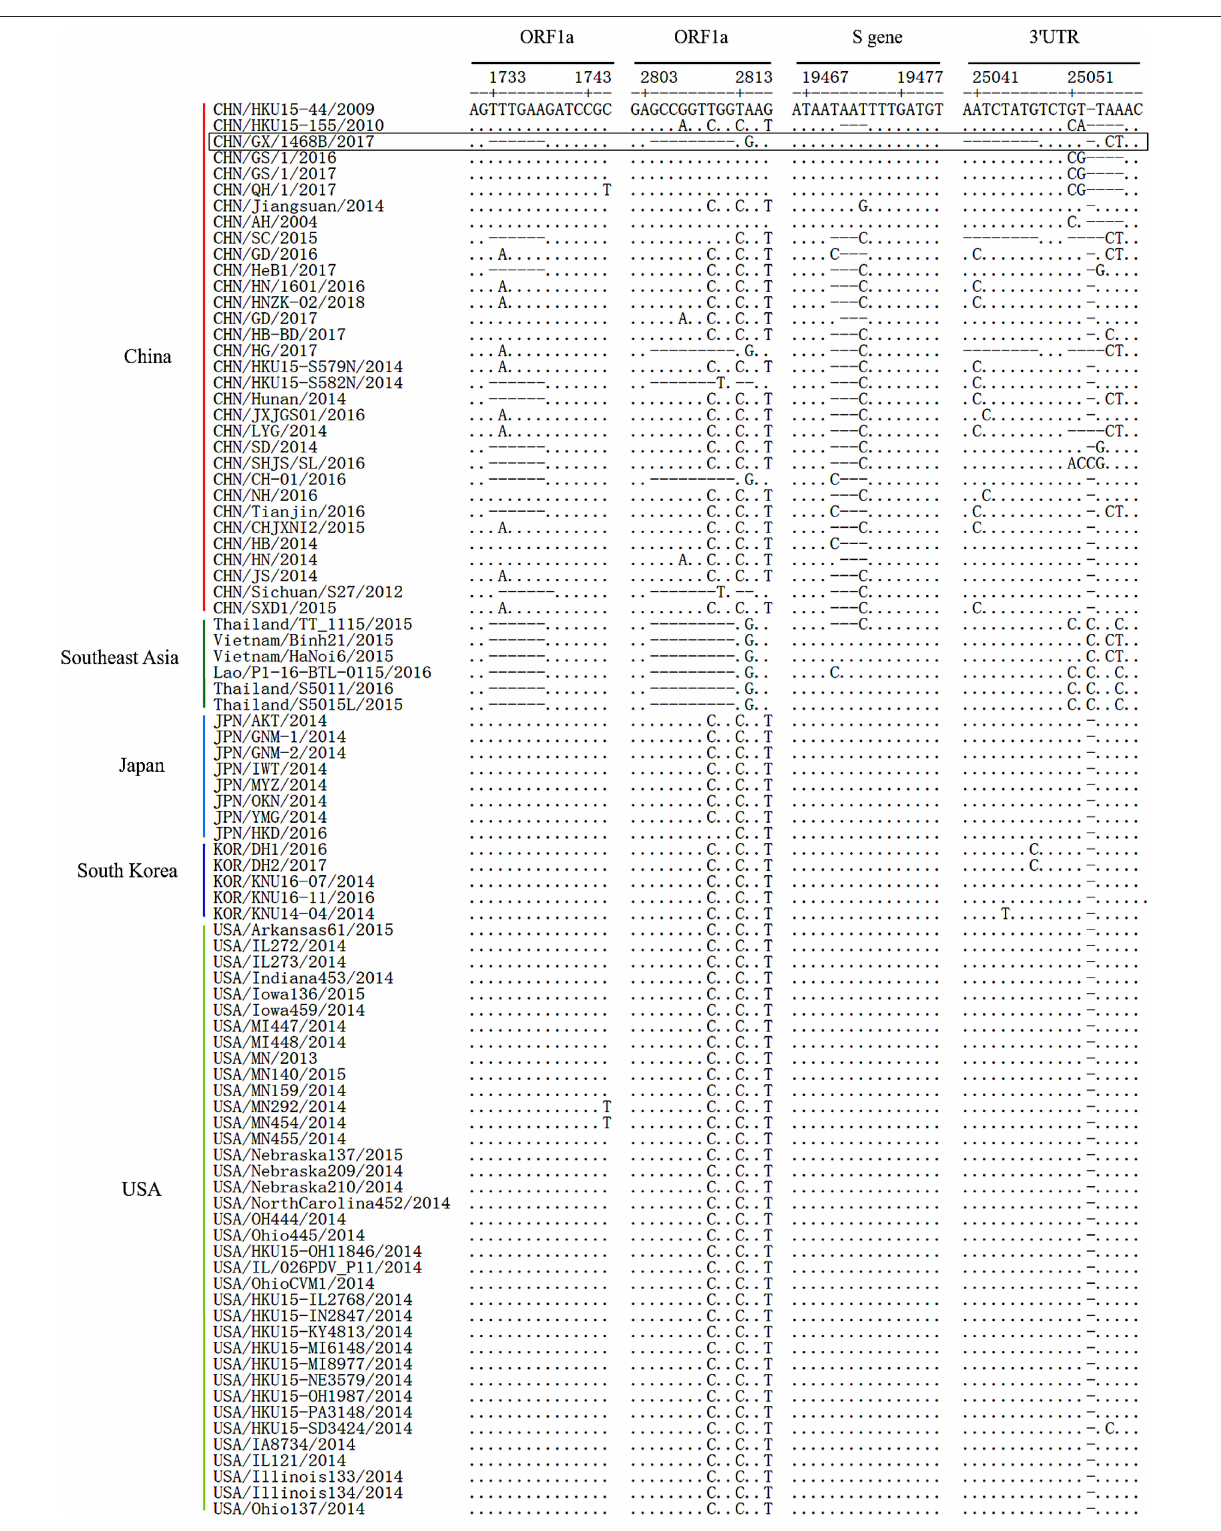
Frontiers in Veterinary Science |